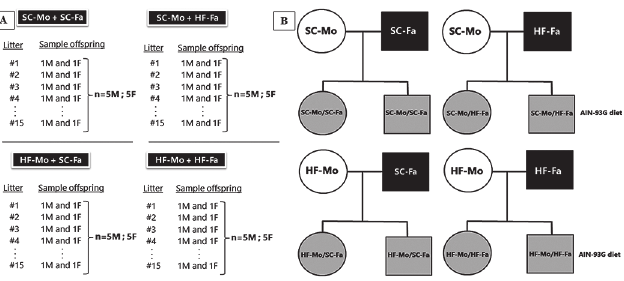
Fig 1. Sampling design and formation of the groups. (A) Sampling design for the study and (B) Scheme of the experimental groups. The letters M and F represent the male and female offspring, respectively (in A). Circles represent the female sex, and squares represent the male sex (in B). Abbreviations: Standard-chow group (SC); high-fat group (HF); father (Fa); mother (Mo). Groups — Father that received standard chow (SC-Fa); Father that received high-fat diet (HF-Fa); mother that received standard chow (SC-Mo); mother that received high-fat diet (HF-Mo); offspring of SC mother and SC father (SC-Mo/SC-Fa); offspring of SC mother and HF father (SC-Mo/HF-Fa); offspring of HF mother and SC father (HF-Mo/SC-Fa); offspring of HF mother and HF father